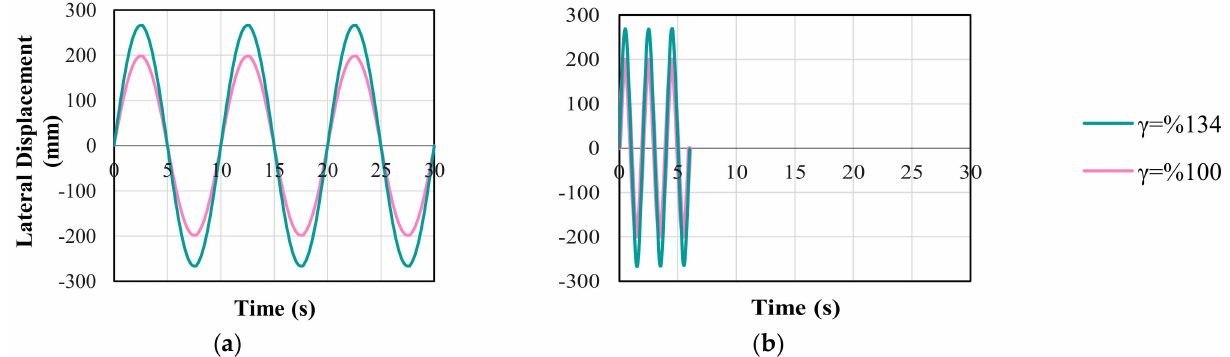
Figure 3. Applied loading history to lead rubber bearing for a frequency of ( a ) 0.1 Hz and ( b ) 0.5